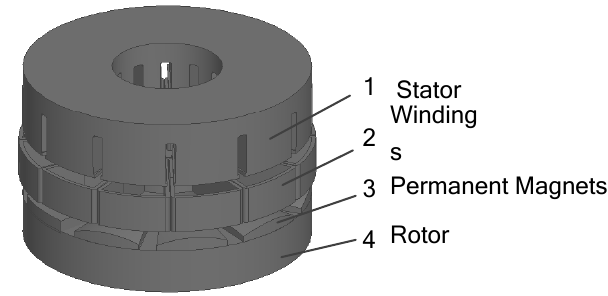
Figure 1. Structure of the Proposed AFPMBLDC.